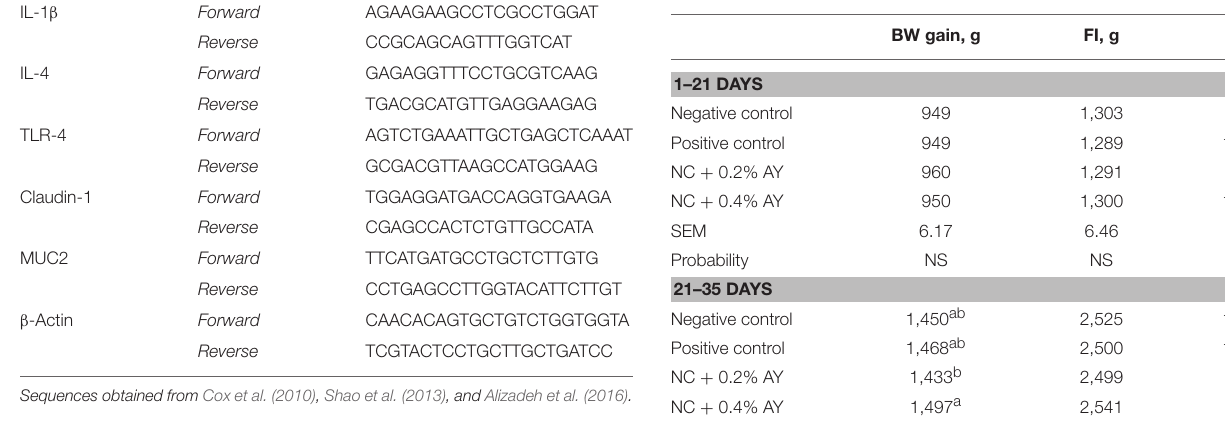
TABLE 3 | Primer sequences used in the real time PCR analysis. TABLE 4 | Growth performance of broiler chickens supplemented with zinc bacitracin or autolyzed yeast of Saccharomyces cerevisiae